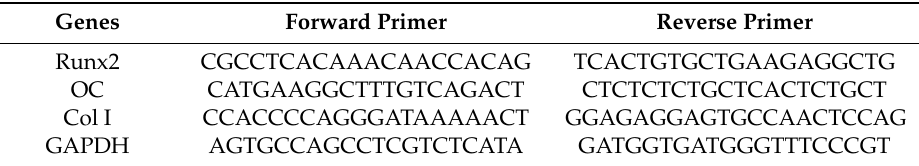
Table 1. Primers for